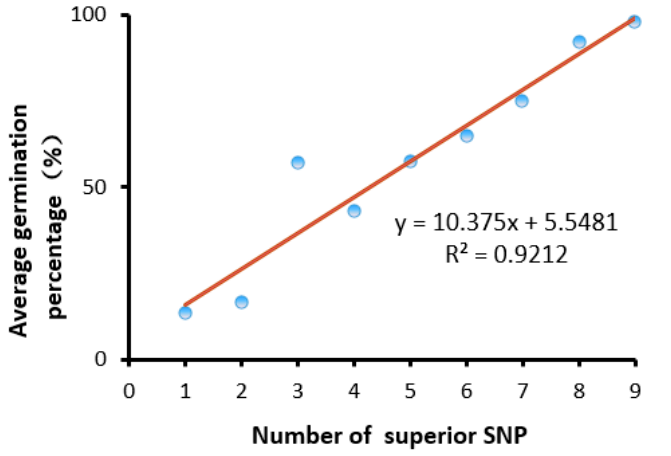
Figure 5. The average germination percentage of pyramiding QTL superior alleles in the whole population. Table 3. The main haplotype analysis of the nine QTLs for seed storability in the whole population (+ superior SNP, − inferior SNP).